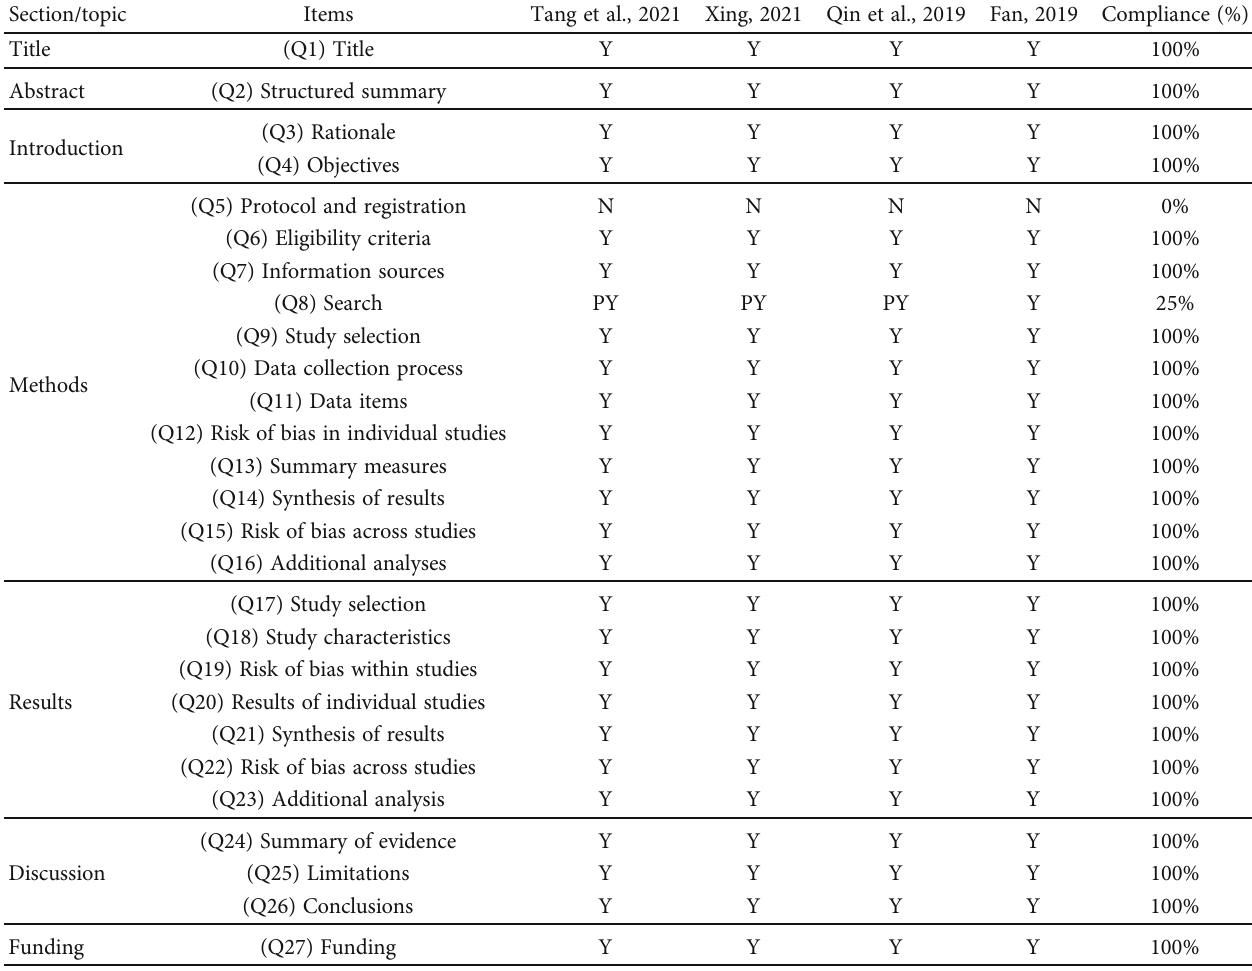
Table 4: Result of the PRISMA assessments.